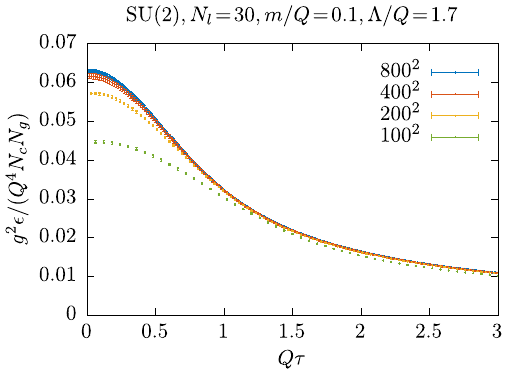
Fig. 6 Total energy density for different transverse lattice sizes N 2 ⊥ with an additional UV cutoff of Λ = 1 . 7